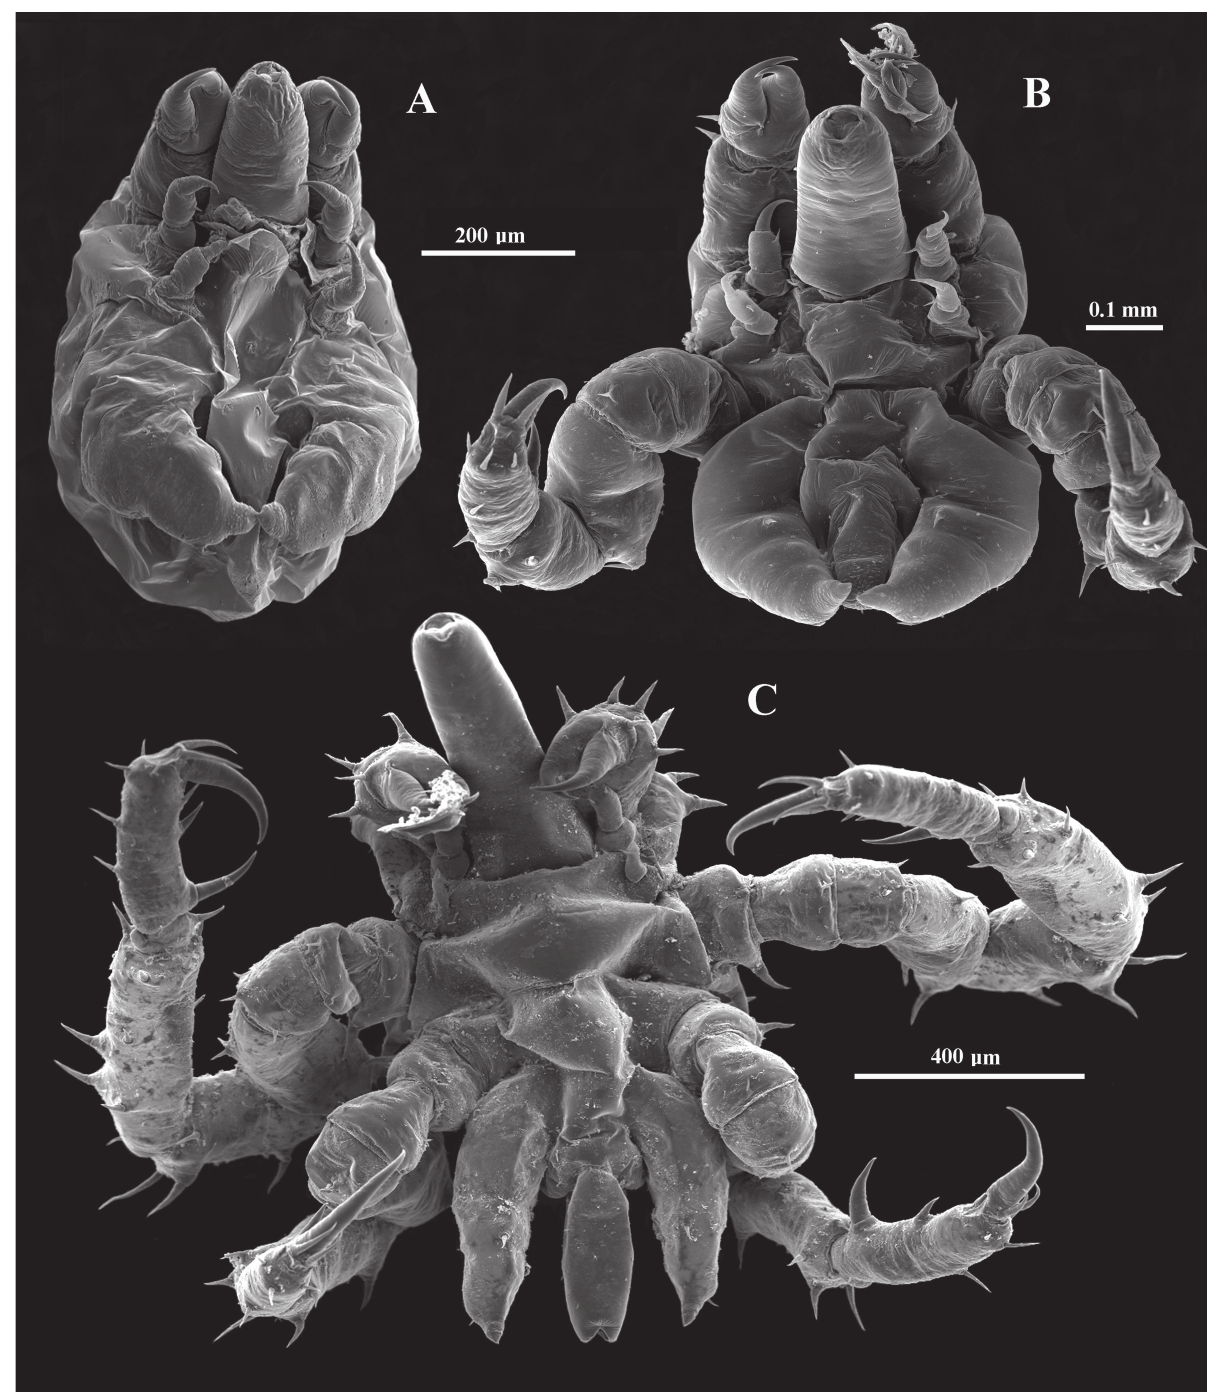
Fig . 4. – larvae of Ammothea glacialis (Hodgson, 1907). sEM photographs: a, second instar larva, ventral view; b, third instar larva, ventral view; C, fourth instar larva, ventral